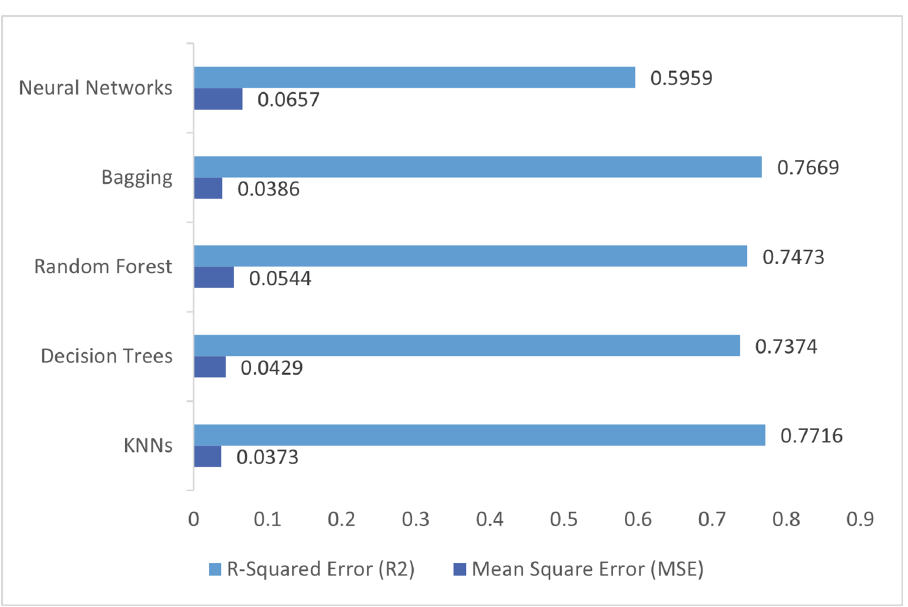
Figure 9. Error scores